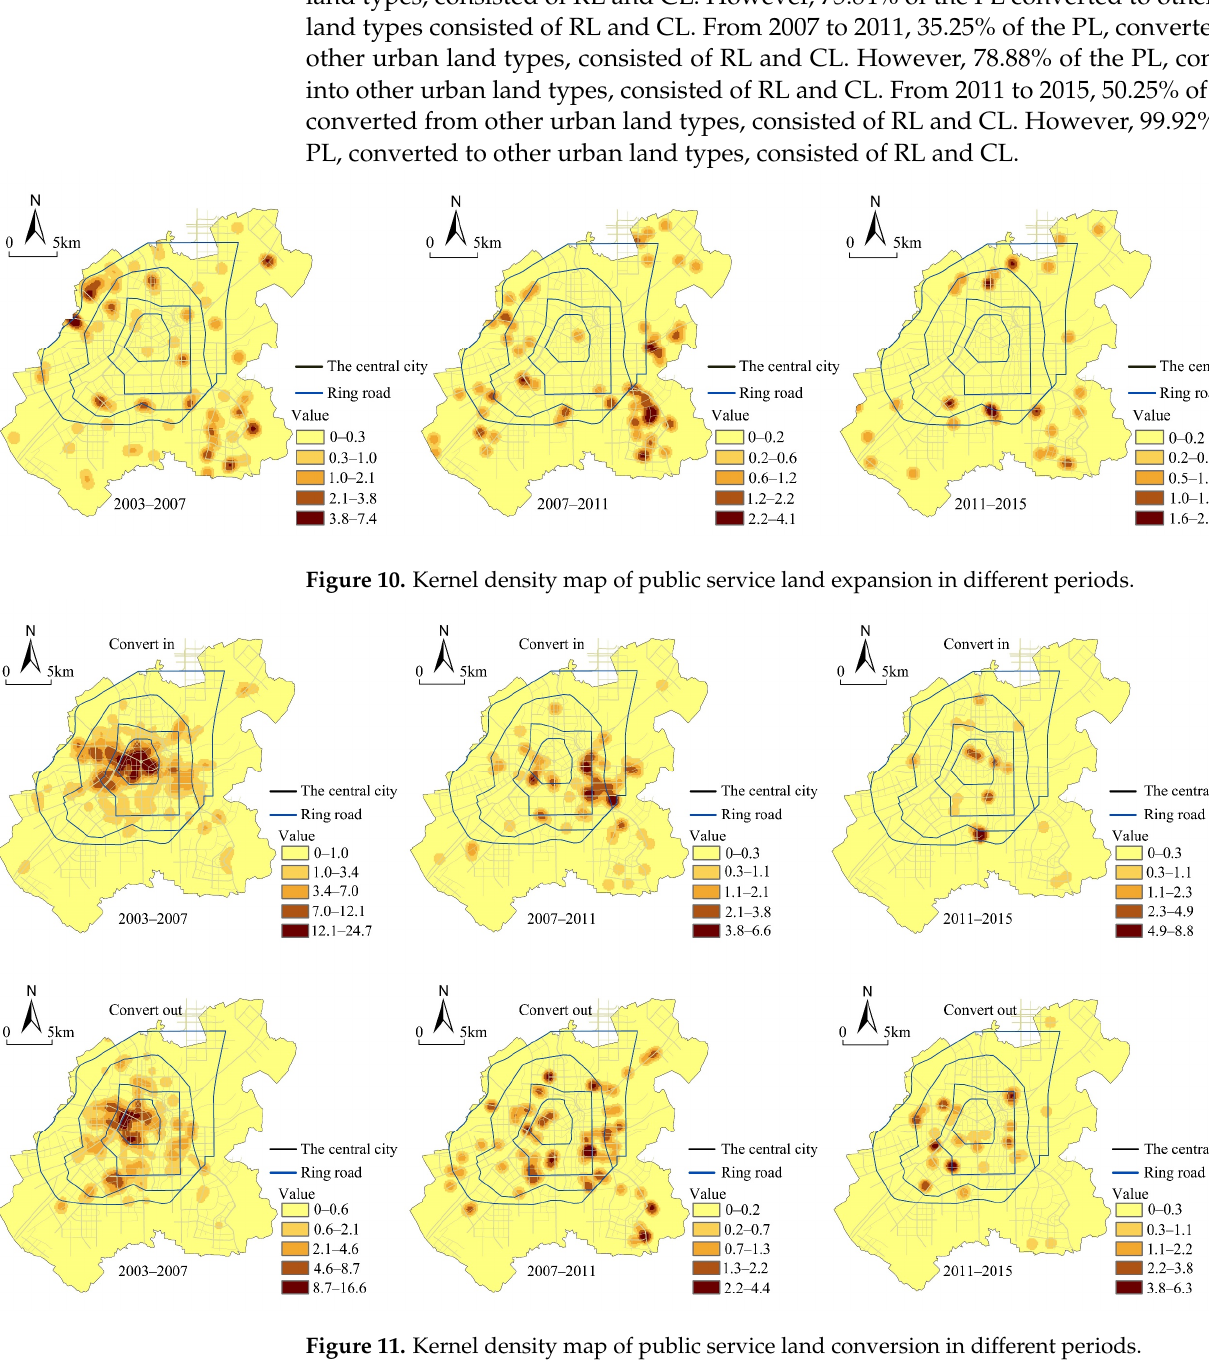
Figure 11. Kernel density map of public service land conversion in different periods.